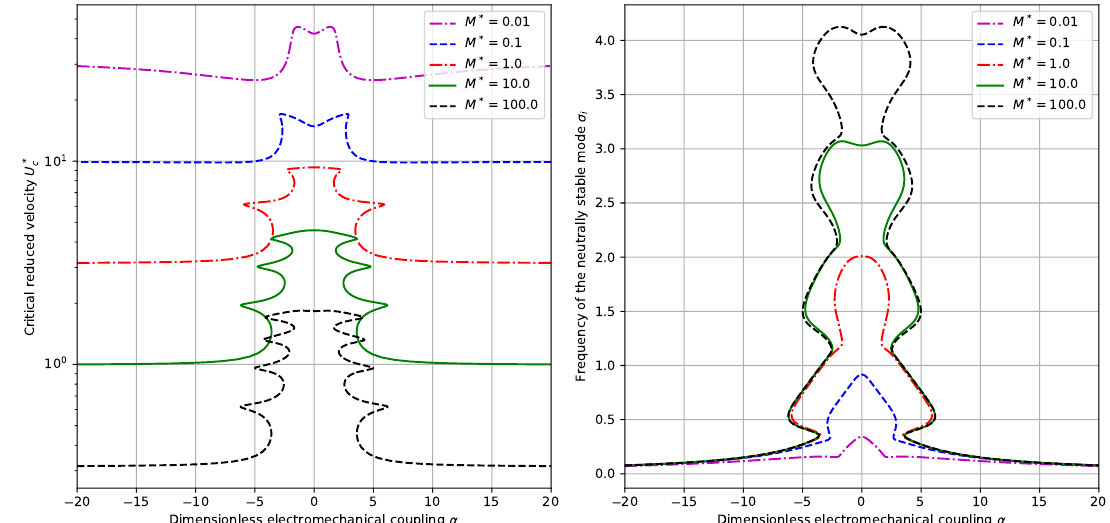
Figure 5. Dependence of the critical reduced velocity U ∗ c ( left panel) and the corresponding neutrally stable frequency σ i ( right panel) upon the electromechanical coupling α and different values of M ∗ . (Here we have β = 1.0).